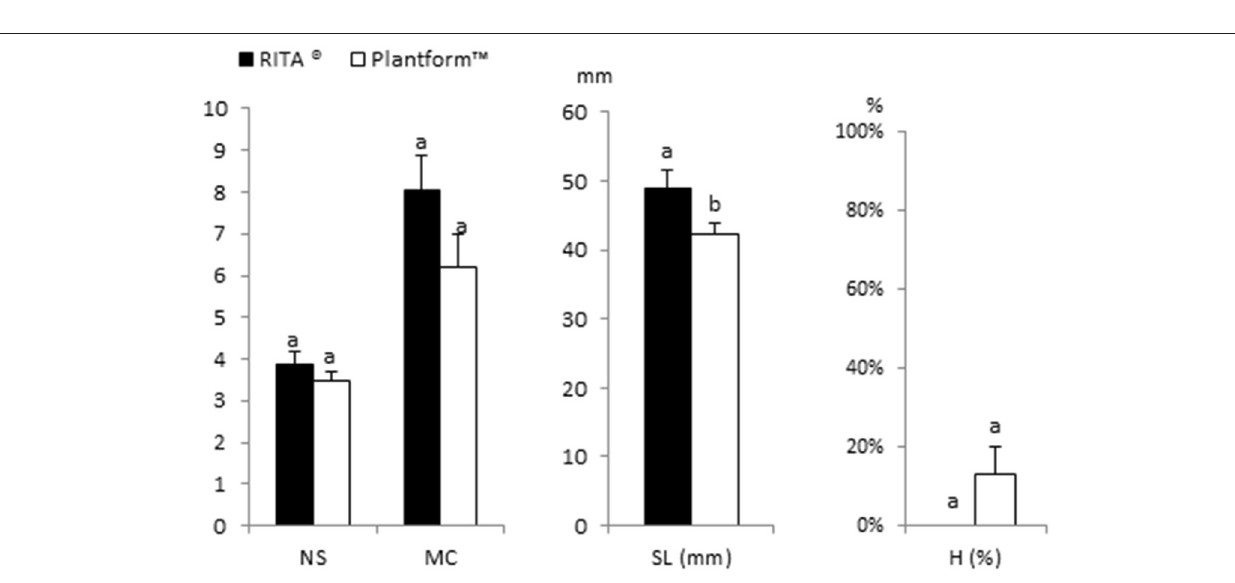
FIGURE 7 | Effect of the type of bioreactor (RITA ® and Plantform TM ) on the proliferation of apical explants of cannabis genotype Beatriz cultured in β -A medium with 2 µ M metatopoline and 0.5% sucrose. Explants were immersed for 1min every 8h. No additional aeration was provided to explants cultured in Plantform TM containers. The data were recorded after 4 weeks of culture. The values represent the mean ± standard error. For each variable, different letters indicate significant differences at p < 0.05. NS, number of shoots per explant; MC, multiplication coefficient; SL, length of the longest shoot (mm); H, percentage of hyperhydric